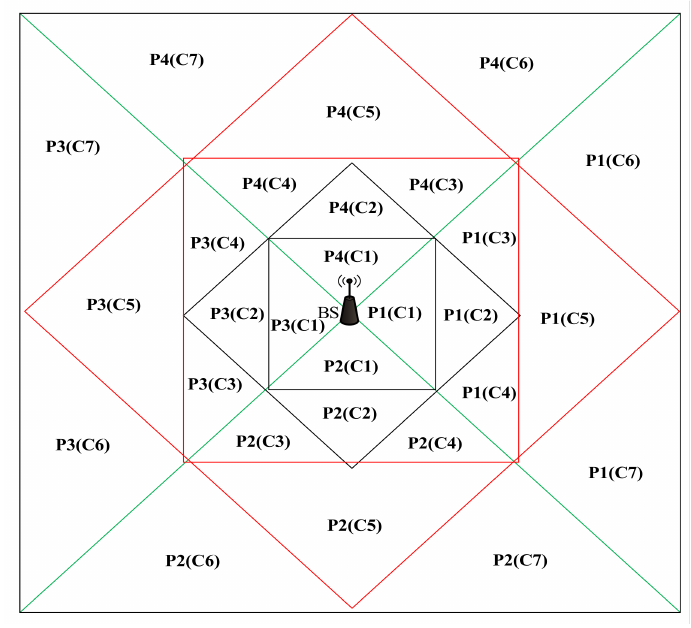
Figure 2. Unequal Sierpinski cluster-tree